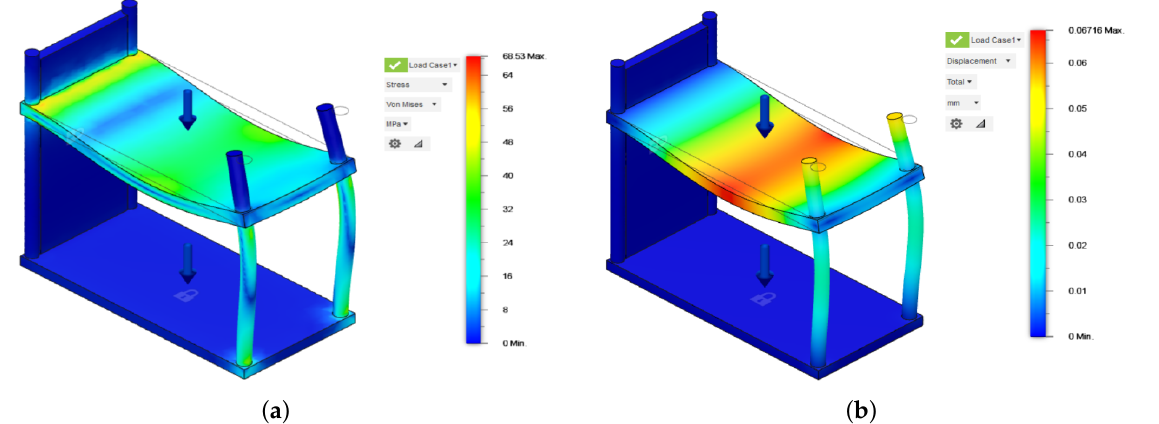
Figure 8. Stress Analysis of the multilevel charging station. ( a ) Von-Mises Stress Distribution of the designed structure. ( b ) Maximum Displacement of the designed